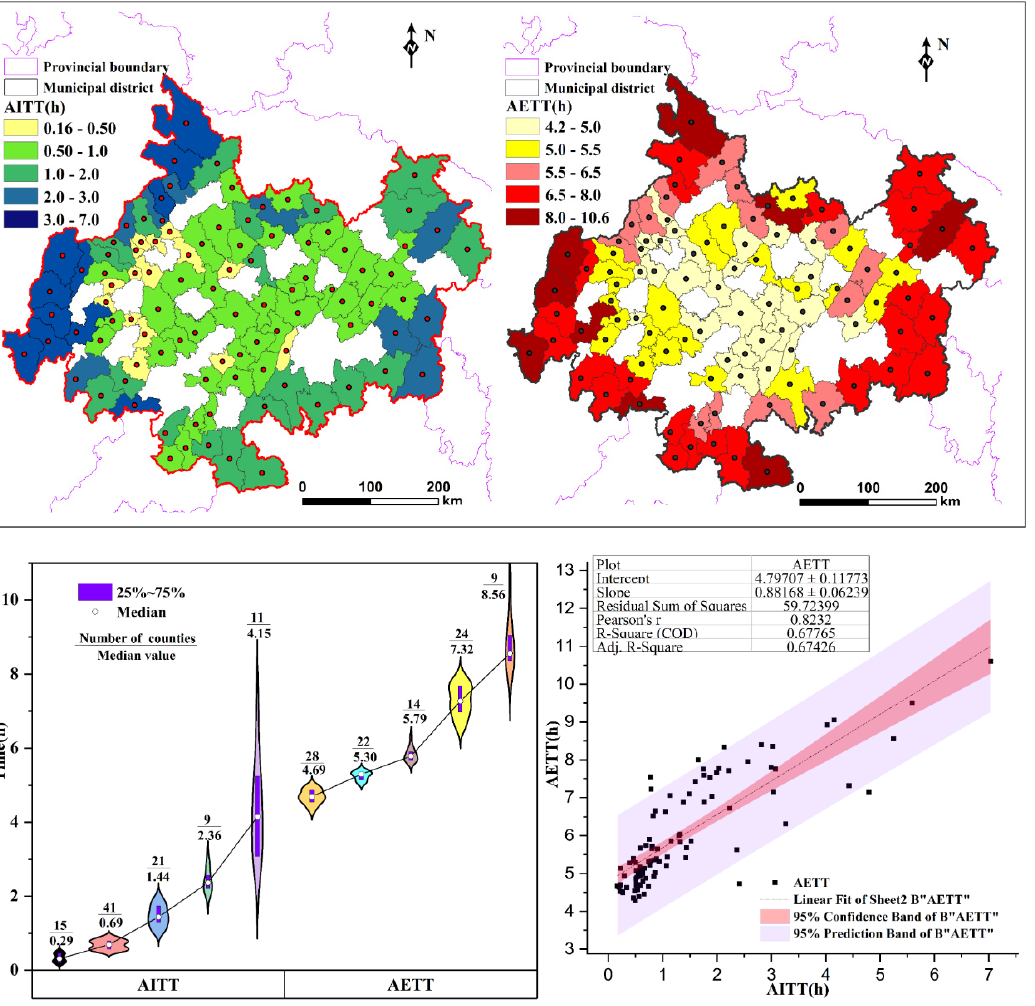
Figure 4. County scale average internal and external travel time in the Chengdu-Chongqing Economic Zone in 2020. Notes: AITT: average internal travel time; AETT: average external travel time. Data source: AITT and AETT values are all from the statistics of the Minimum Cost Distance